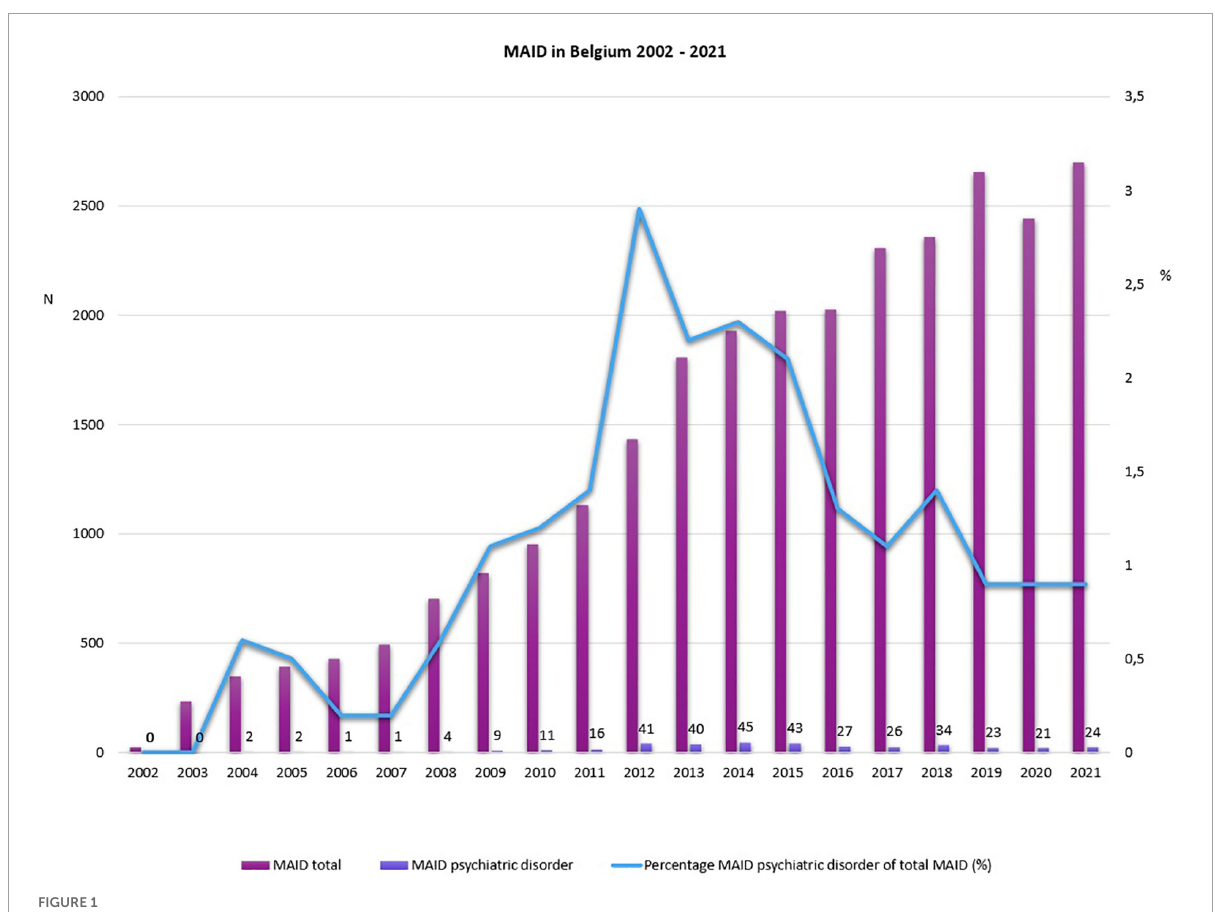
FIGURE1 Medical assistance in dying (MAID) in Belgium (adapted from